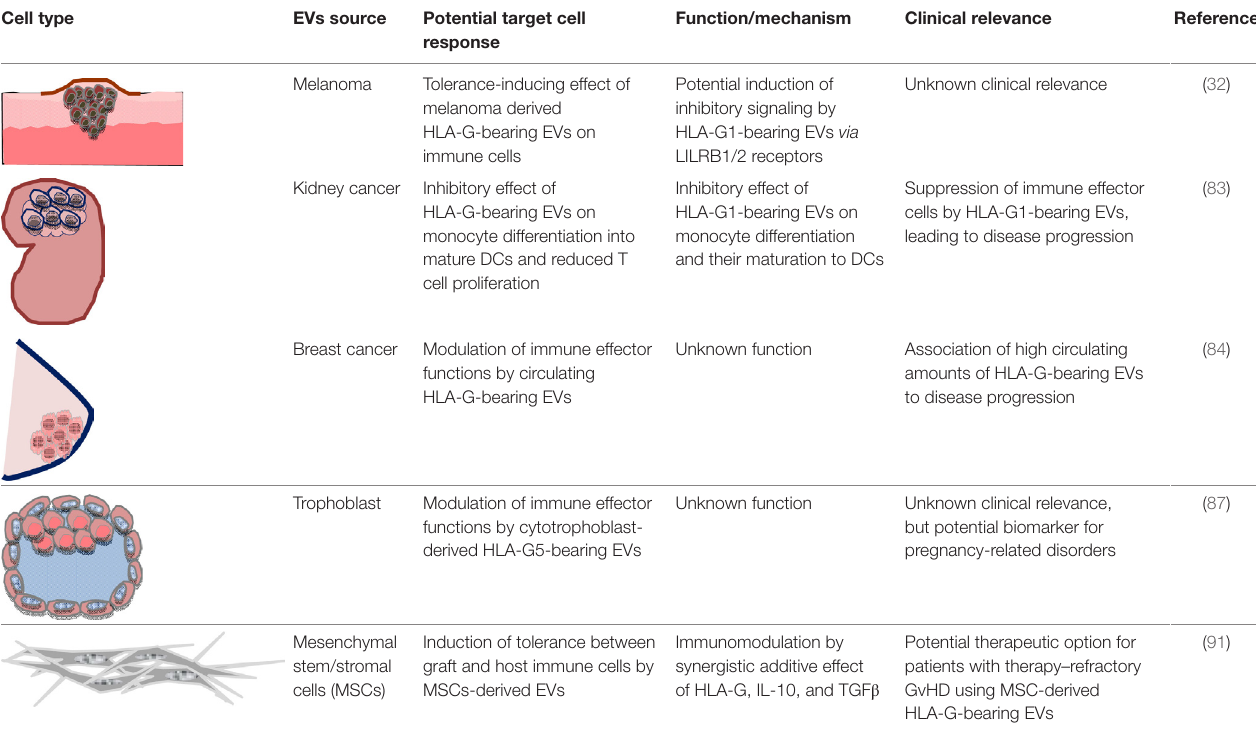
tABLe 1 | source of HLA-G-bearing evs with potential immunological and clinical relevance. cell